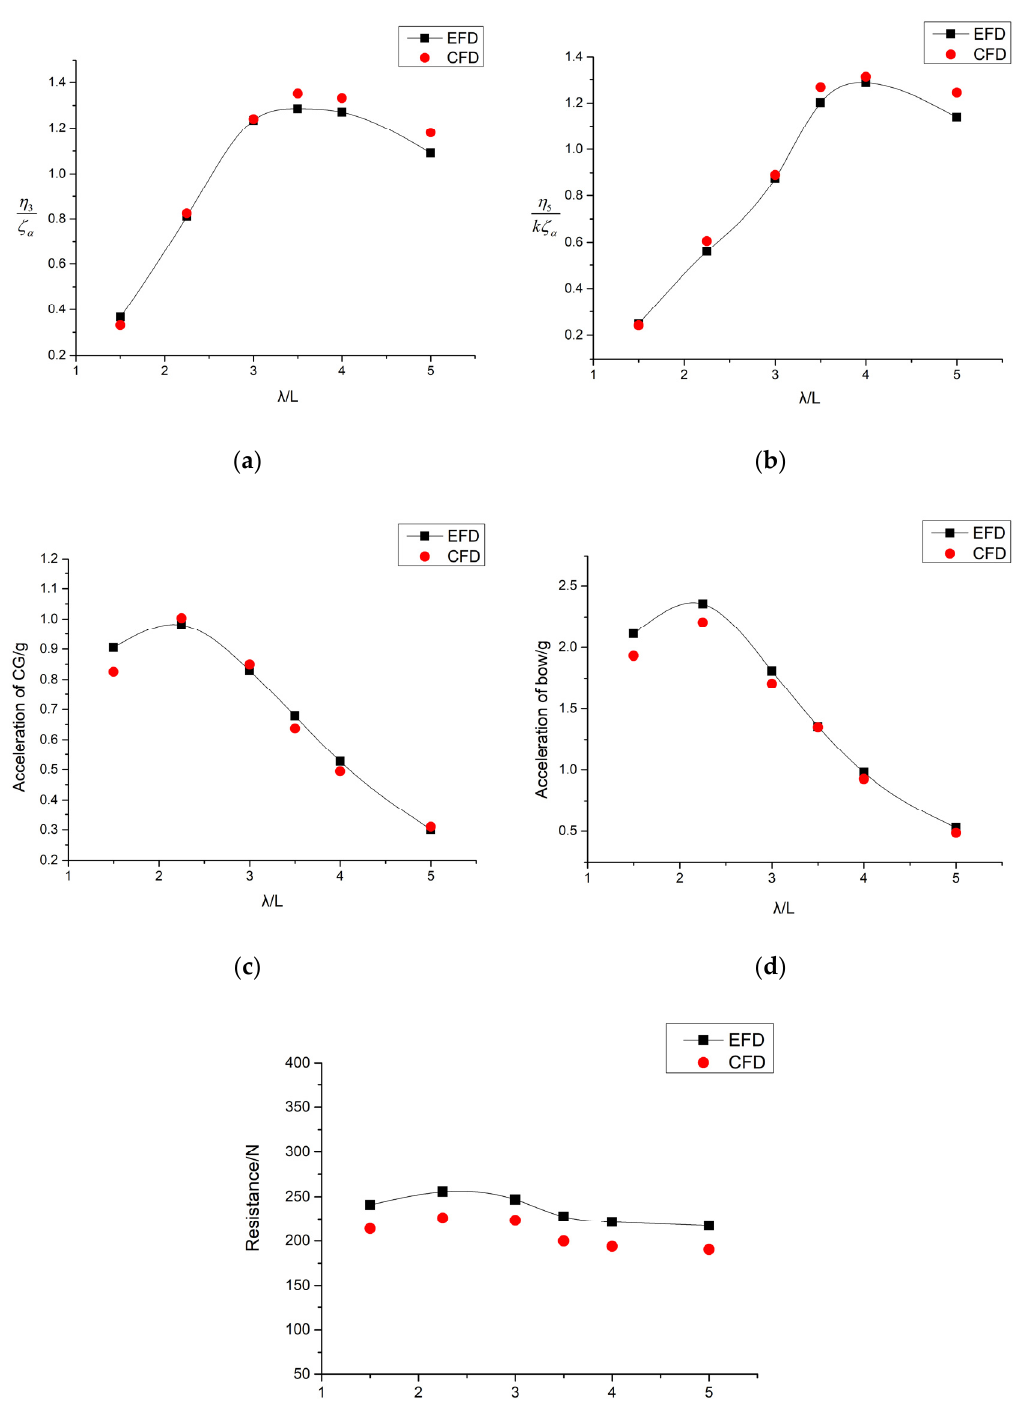
Figure 14. Comparison of the numerical and tested results: ( a ) Amplitudes of the heave; ( b ) Amplitudes of the pitch; ( c ) Amplitudes of the acceleration of the CG; ( d ) Amplitudes of the acceleration of the bow; ( e ) Average values of the resistance.